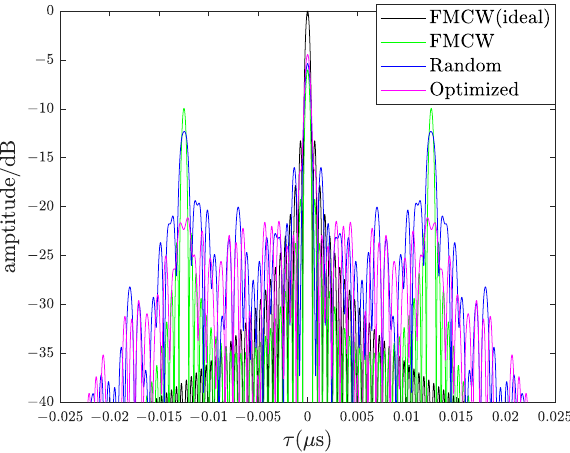
Figure 9. Range profile comparison of different waveforms when the jamming parameters are